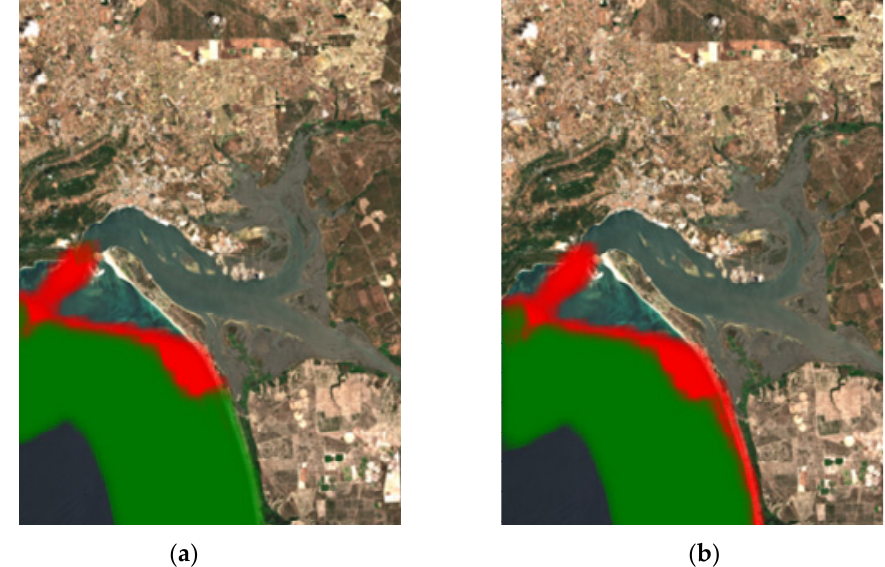
Figure 13. ( a ) Neural Network Prediction; ( b ) final decision considering land use data.